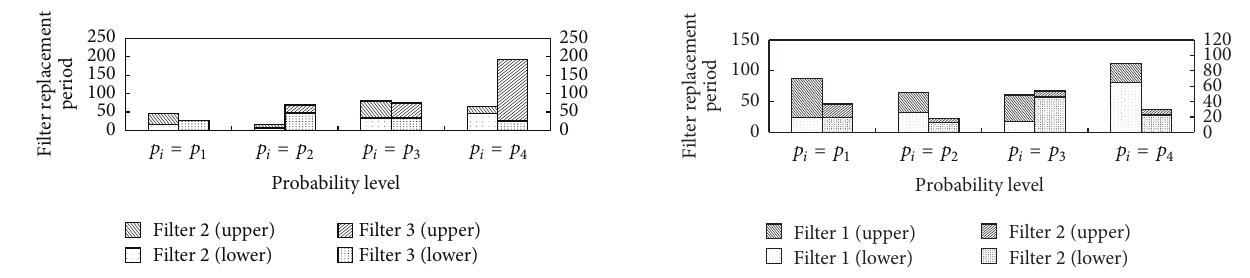
Figure 8: Filter replacement periods for Scenario 3 under high contaminant ingression/generation level.